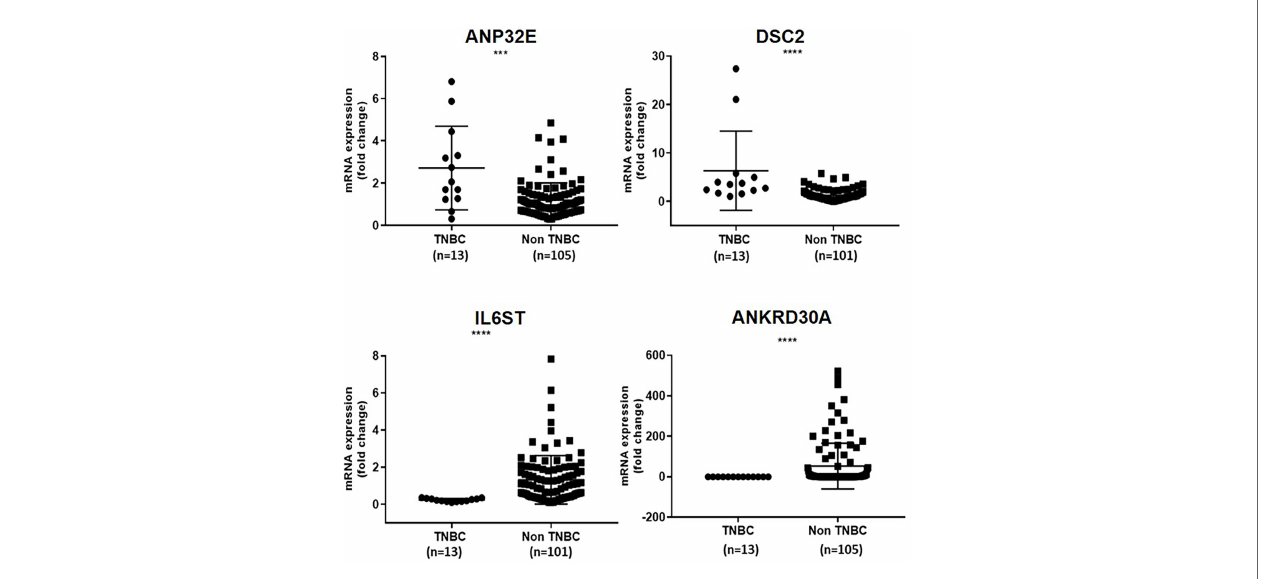
FIGURE 2 | Veri fi cation of differential expression of ANP32E, DSC2, IL6ST and ANKRD30A genes in TNBC compared to non-TNBC at the mRNA level in the second cohort. The mRNA expression of ANP32E, DSC2, IL6ST and ANKRD30A genes obtained as copies per m l using ddPCR. Results are shown as fold change expression of target genes in TNBC compared to non-TNBC. Values are presented as the median ± interquartile range. A Mann Whitney test was used to determine the statistical signi fi cance of the expression in TNBC. A p value ≤ 0.05 was considered signi fi cant. Asterisks in the fi gure represent statistical signi fi cance (***p ≤ 0.001, ****p ≤ 0.0001).